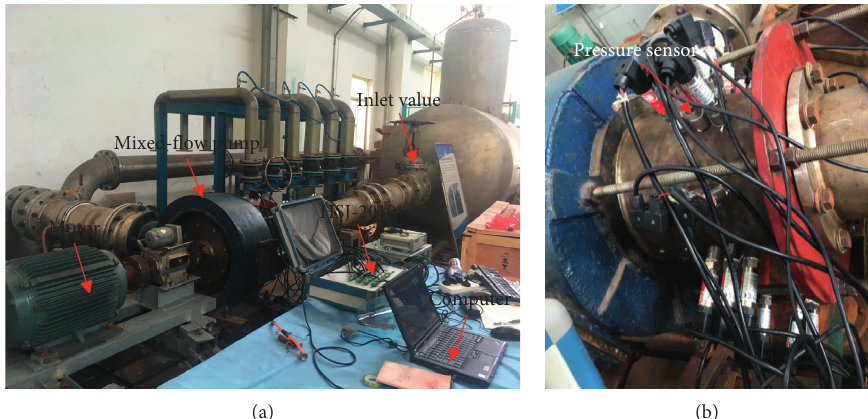
Figure 4: Arrangement of external characteristic and pressure pulsation measurement.